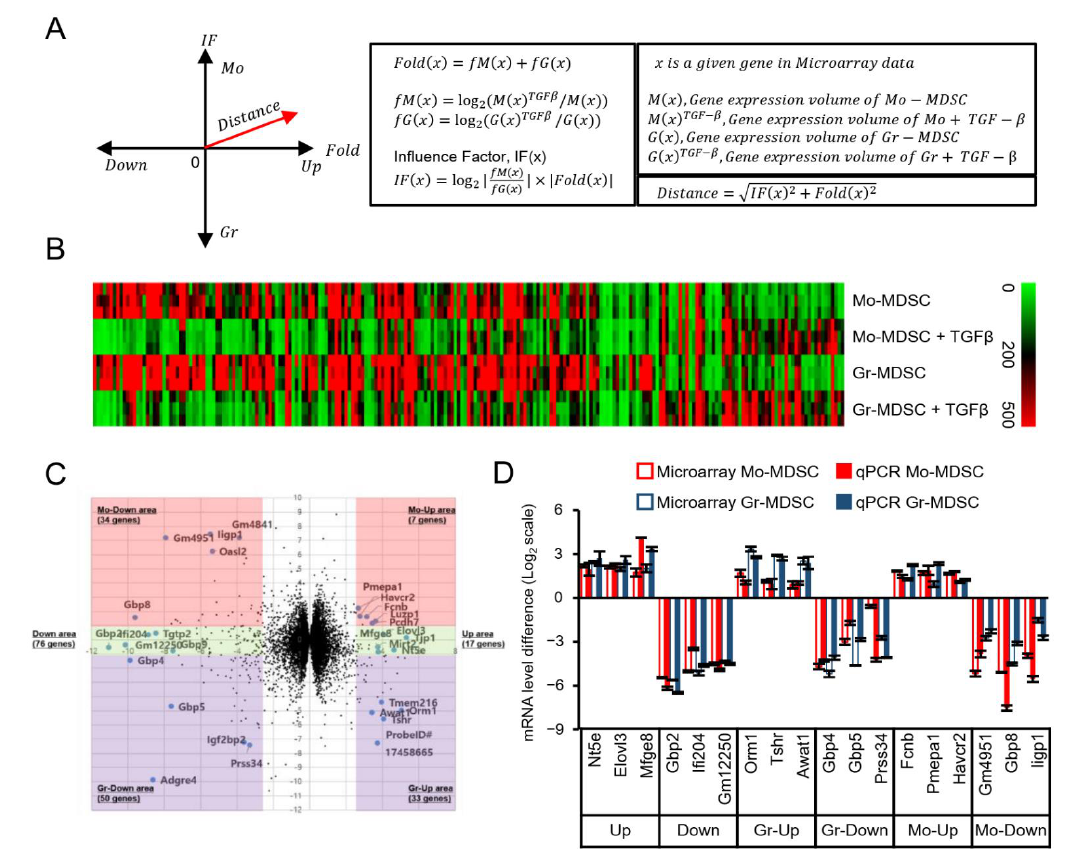
Figure 2. Gene expression profile in response to TGF- β treatment. ( A ) Graphical scheme and calculation scheme used in the two-dimensional plot. ( B ) Heat map of genes with a ‘Fold’ value > 2.5 in three independent microarray experiments. ( C ) Two-dimensional plot of genes from the microarray data. The X -axis represents ‘Fold’ and the Y -axis represents ‘IF’. ( D ) The top three genes in each of the groups were confirmed by qPCR. The changes in the mRNA levels upon TGF- β treatment by microarray or qPCR are shown. Data are expressed as the mean ±